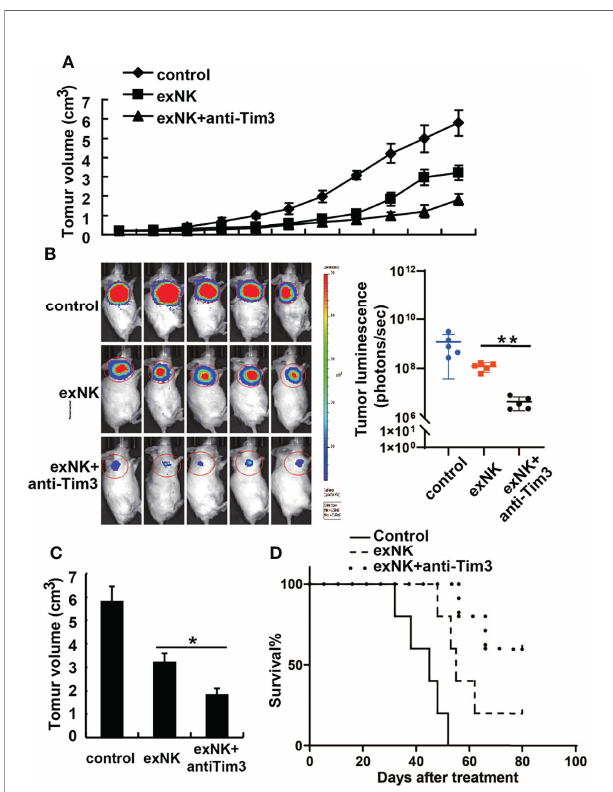
FIGURE 7 | Anti-tumor effects of Tim-3 blockade NK cells on human MM tumor-bearing NOD/SCID mice. (A – C) Female NOD/SCID mice were subcutaneously injected with 1×10 7 RPMI8226 cells and then intravenously injected with 1×10 8 exNK cells with anti-Tim3 or isotype antibodies on day 7 and 14 post of tumor cell inoculation. The tumor volumes of tumor-bearing mice were measured every 3 days. The tumor burden was monitored by bioluminescence imaging with the IVIS system and the total tumor luminescence (photons/sec) of the tumors were measured. (D) NOD/SCID mice were i.v. injected with 2×10 6 RPMI8226 cells and then injected intravenously with 2×10 7 exNK cells with anti-Tim3 or isotype antibodies on day 7 and 14 post of tumor cell inoculation. The curves for the survival were shown as percentages of the initial number of animals per group. * P < 0.05, ** P < 0.01 versus control NK